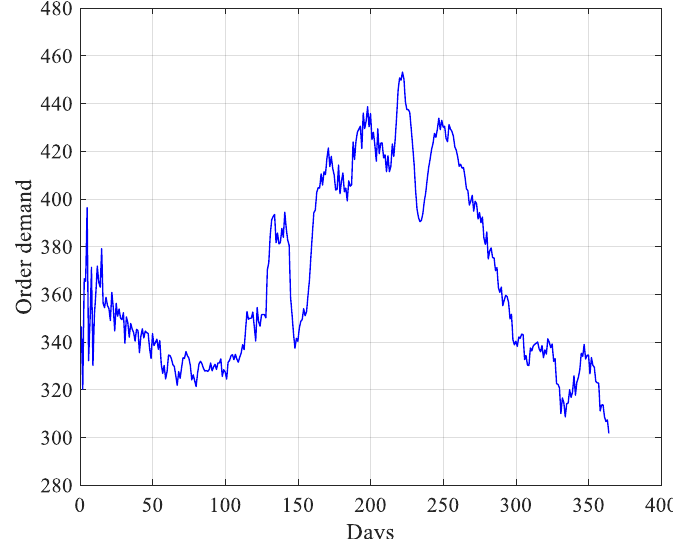
Figure 7. Reconstructed signal diagram.